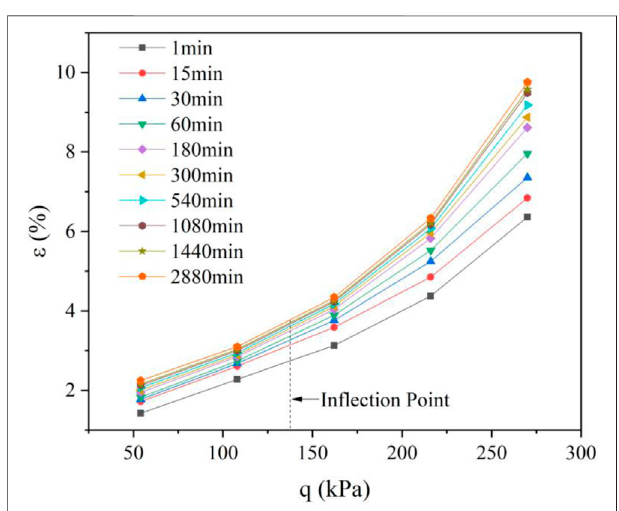
FIGURE 2 | Stress-strain isochronous